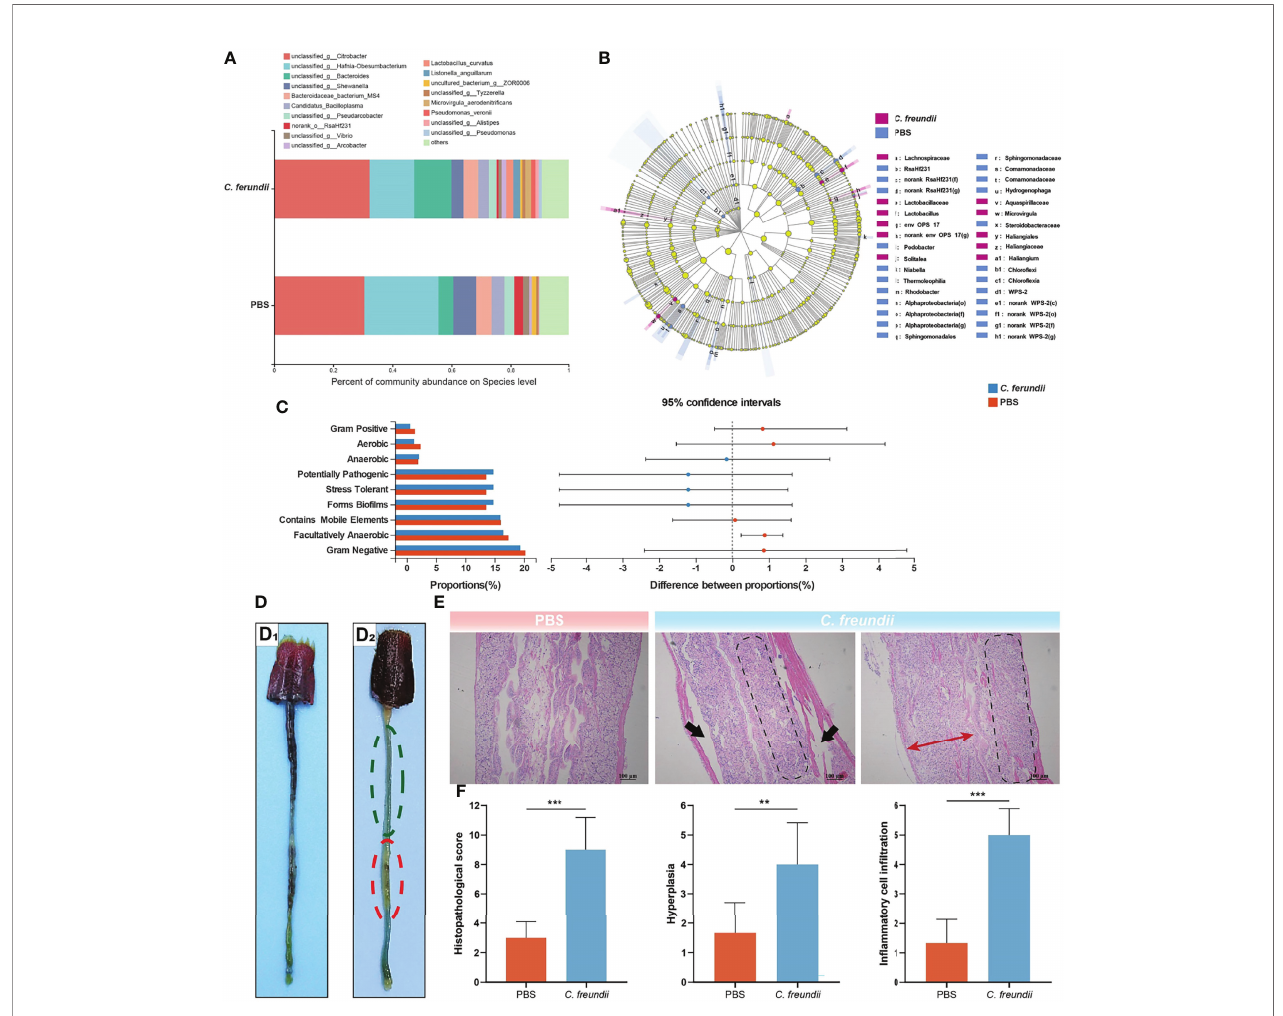
FIGURE 1 | Effects of C. freundii infection on intestinal microbiota composition and intestinal structure. (A) Intestinal microbiota composition at the species level in different groups of the cray fi sh. (B) Taxonomic representation of differences in the intestinal microbiota of cray fi sh injected with PBS and C. freundii . The concentric circles from the inside out represented the different taxonomic classes (phylum to genus). The different coloured nodes indicated differences in intestinal microbiota (Red represented signi fi cantly higher abundance of intestinal microbiota in the infection group than in the control group, while blue represented the opposite, and yellow indicated no signi fi cant difference). The size of each node indicated the abundance of intestinal microbiota. (C) Prediction of microbial community phenotype based on BugBase. (D) General characteristics of the intestine of cray fi sh in the control (D 1 ) and infected groups (D 2 ). More areas of intestinal in fl ammation (Green dotted circle); The intestinal segment was in fl ated and swollen (Red dotted circle). (E) Histopathological observations on the intestine of the cray fi sh (H&E staining). The muscularis is separated from other tissue (Black arrow); Intestinal wall cell hyperplasia (Red bidirectional arrow); In fl ammatory cell in fi ltration (marked by parallelogram shape). (F) Intestinal histopathological score. (*:p < 0.05; **:p < 0.01; ***:p <